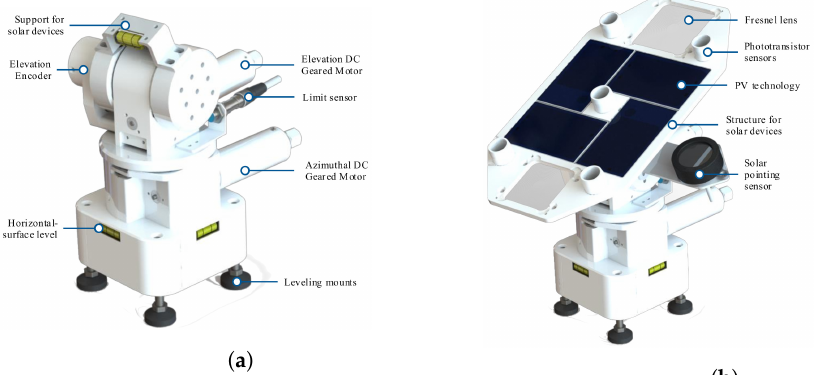
Figure 8. Optimal design obtained by proposed concurrent design strategy. ( a ) Isometric view of the obtained optimal design, and ( b ) example of multiple solar devices mounted on the